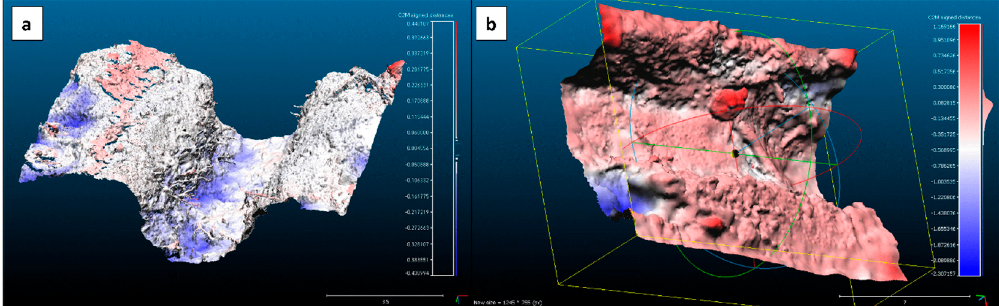
Figure 7. Final model using TEPHOS. ( a ) Model used to highlight the effect of roots and soil structure; ( b ) model used to highlight the effect of the embedded rocks.